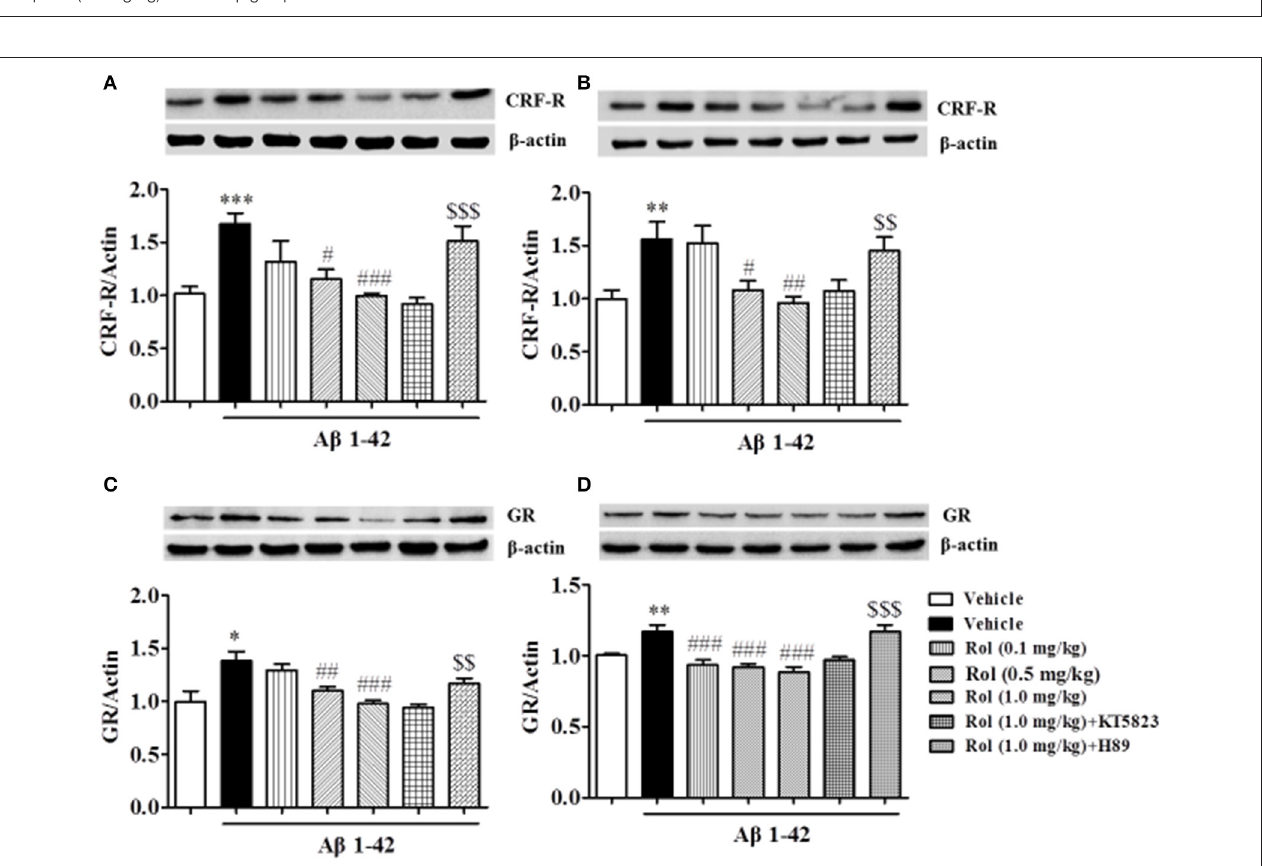
FIGURE 6 | The effects of rolipram on A β -induced changes in CRF receptor and GR expression in the hippocampus (A,C) and in the cortex (B,D) of mice. Values shown are means ± SEM, n = 10; * p < 0.05, ** p < 0.01, and *** p < 0.001 vs. vehicle-treated control group. # p < 0.05, ## p < 0.01 and ### p < 0.001 vs. vehicle-treated A β group. $$ p < 0.01 and $$$ p < 0.001 vs. rolipram (1.0mg/kg)-treated A β group.